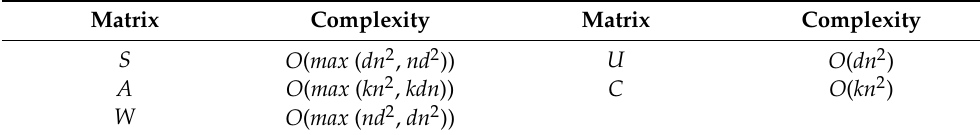
Table 2. Computational complexity of each variable.